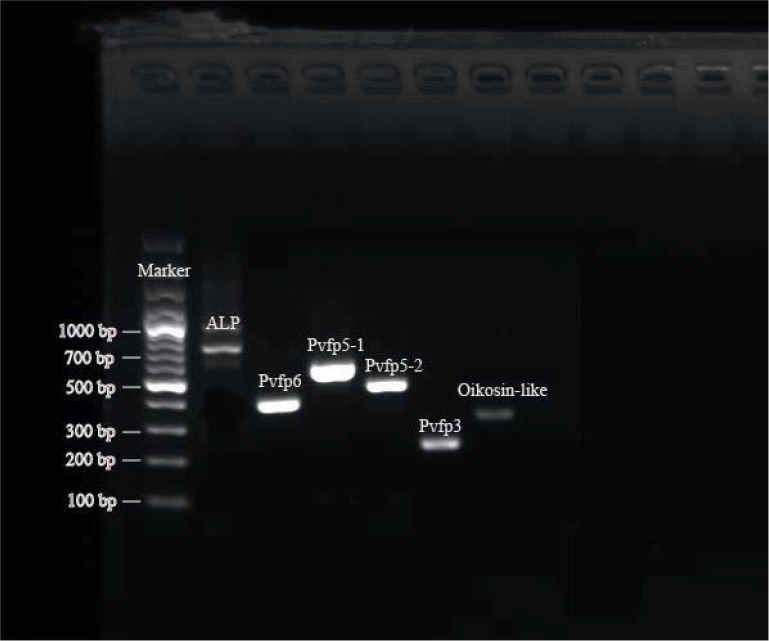
Validation of byssal proteins by RT-PCR with further confirmation by Sanger sequencing.